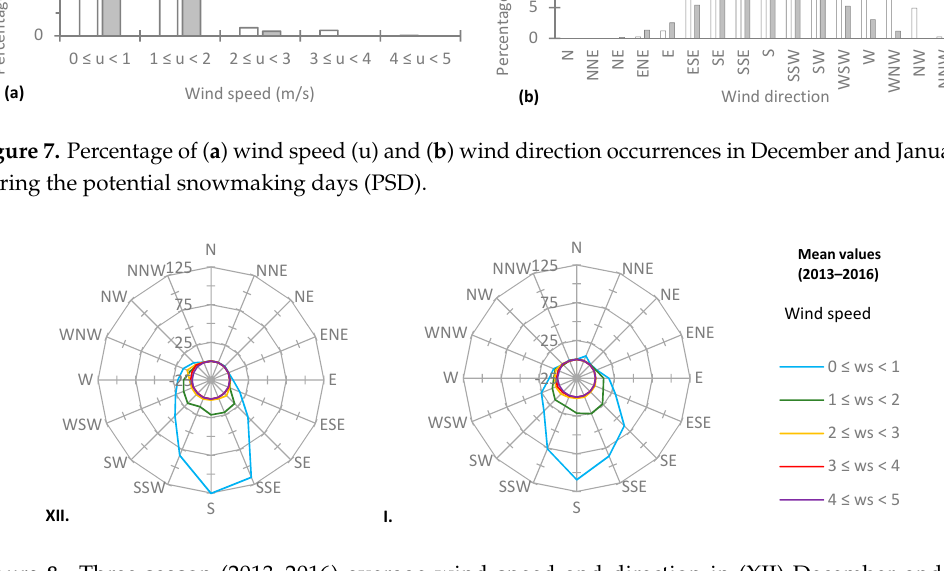
Figure 8. Three-season (2013–2016) average wind speed and direction in (XII) December and (I) January. The graph axis displays the average number of hours. The sum of the displayed hours is 676 in December and 667 in January. Wind roses were created from the mean hourly wind speed and direction data.